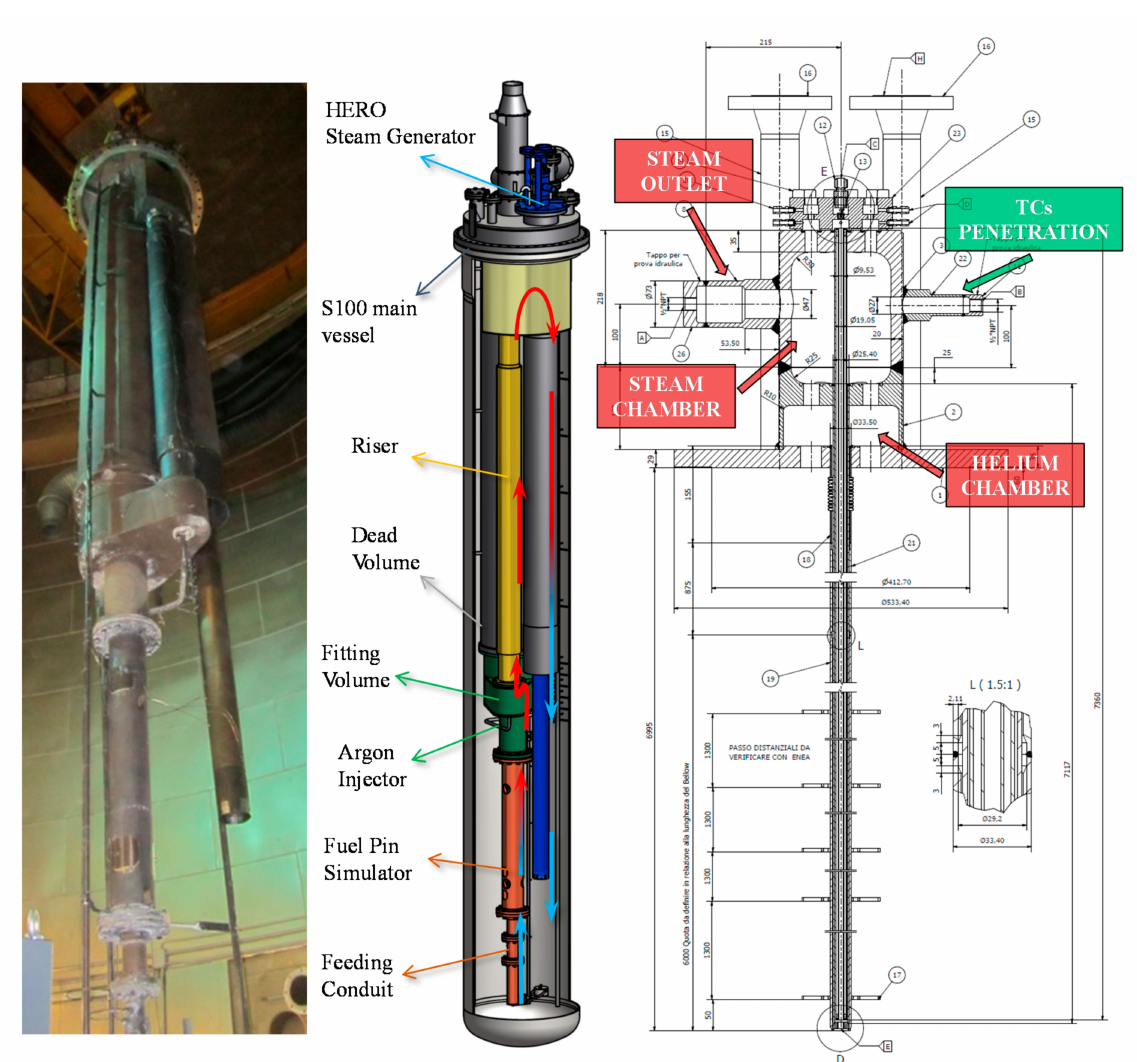
Figure 1. A 3D sketch of CIRCE-HERO and a technical drawing of the HERO SGBT. A dedicated once-through secondary loop is installed to feed the SGBT with deminer- alized water at high temperature and pressure (up to 18 MPa). The water loop, depicted pump, a helical pre-heater, and a manifold for the water distribution among the seven BTs.